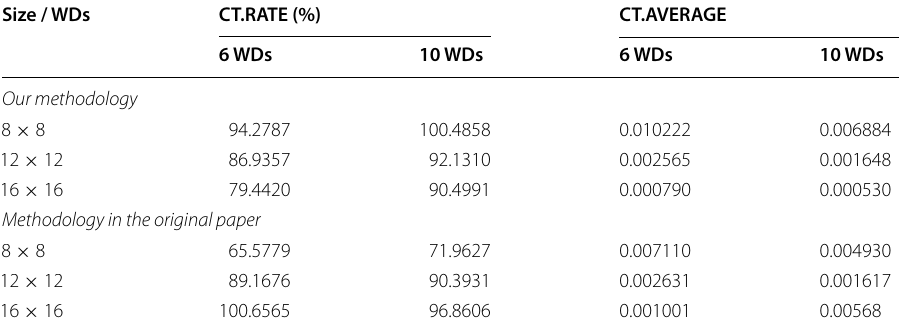
Table 1 CT.RATE and CT.AVERAGE values of our methodology and the methodology in the original paper